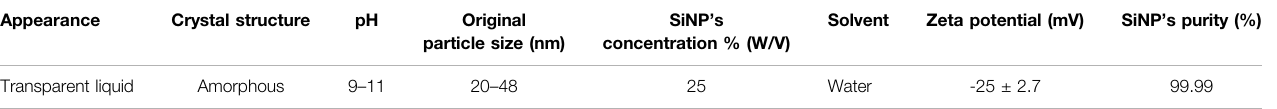
TABLE 1 | Speci fi cations of the investigated silica nanoparticles emulsion used in this